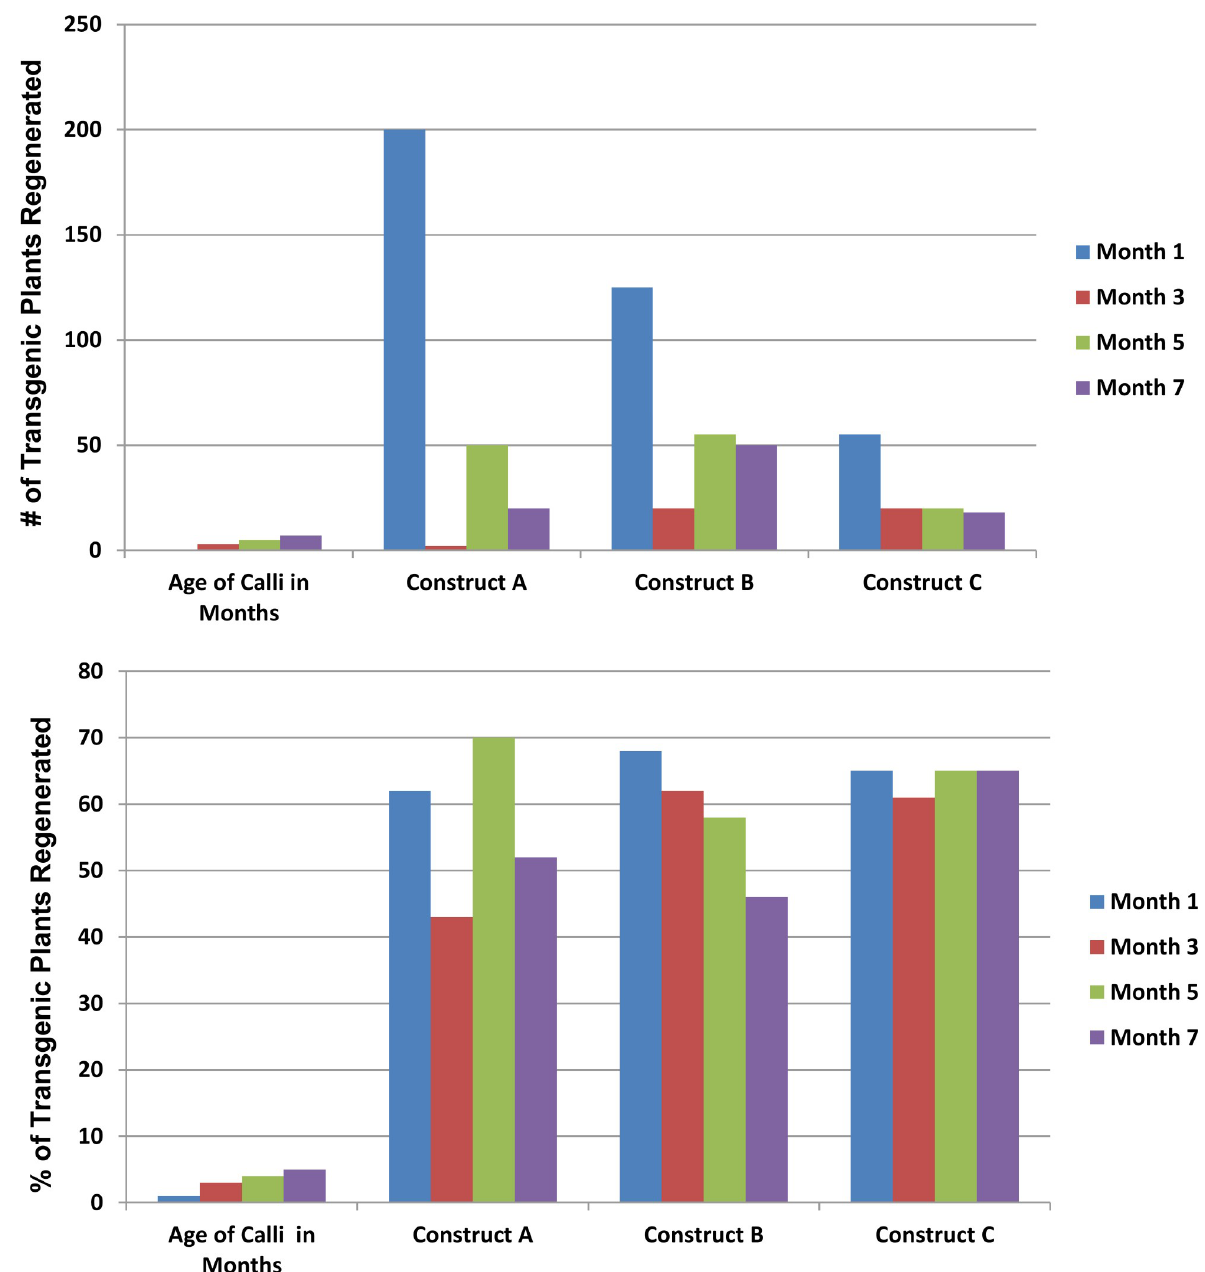
Fig 3. Callus induction, co-cultivation and Agrobacterium -mediated genetic transformation of Japonica rice variety Taipei 309. (A) and (B) High frequency plant regeneration from GFP expressing transformed calli. (C, D, E) High expression of GFP in the callus and roots of the transgenic plants; control roots did not show any GFP expression under confocal microscope (F, G) Creamy white to yellow nodular embryogenic calli proliferated well upon subculture, and 3 month old embryogenic calli (H) Selection and proliferation of hygromycin resistant calli on selection medium harboring constructs A , B and C . (I) The regenerated calli transferred on RM-I showing appearance of green spots after 3–4 weeks, produced more than one shoot derived from constructs A, B and C. (J) Regenerated transformed shoots were transferred to RM-II produced multiple shoots and well developed roots derived from constructs A, B and C. (K) The well developed putative transgenic plants derived from constructs A, B and C were transferred to plastic pots and maintained in Phytotron for acclimatization, hardening and further proliferation. (L) The transgenic plants of GFP , A, B, C construct and wild type were maintained in Phytotron for panicle formation, seed setting and grown till maturity.